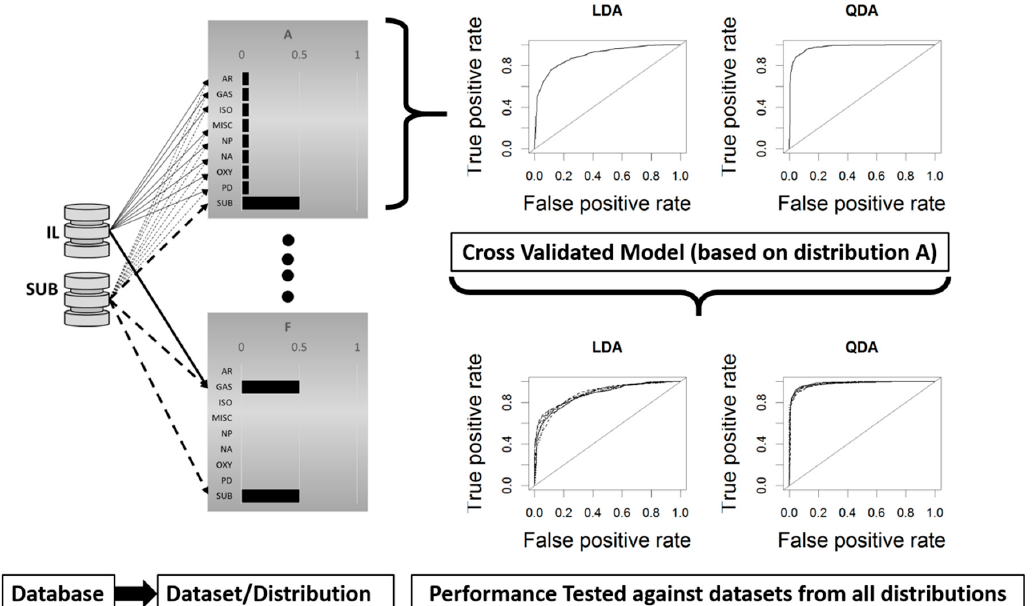
Figure 2. Procedure and results for developing LDA and QDA models based on a dataset having distribution A (Table 1) and testing the model with datasets having distributions A–F (Table 1).